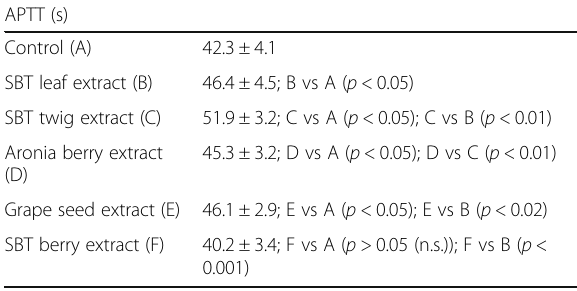
Table 3 Comparison of anticoagulant properties of SBT twig and leaf extracts with properties of selected berry extracts (50 μ g/mL; 30 min). Data represent means ± SD of 12 –